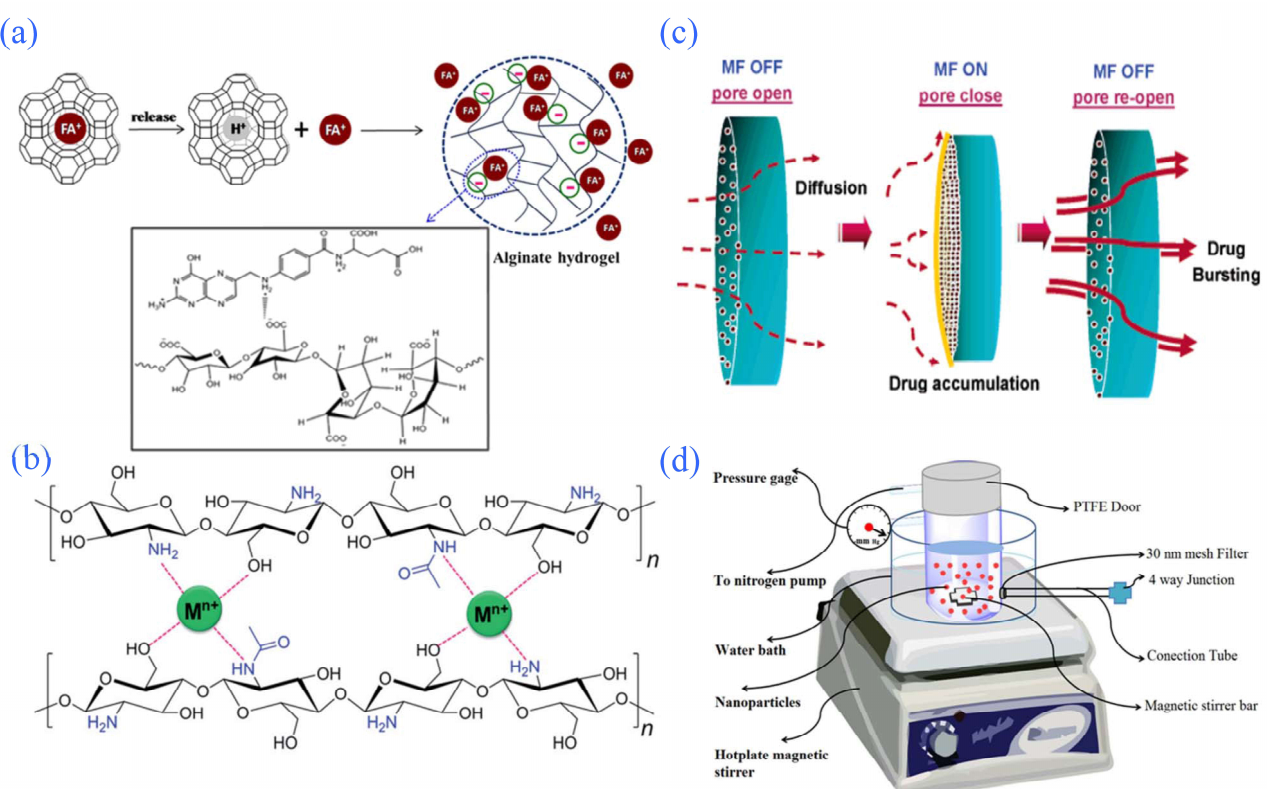
Figure 6. Partial intelligent-response hydrogel controlled-release system. ( a ) Proposed mechanism of FA release from zeolite FAY/alginate hydrogel. Reprinted with permission from Ref. [88]. Copyright 2015, Paradee, N. ( b ) Chemical structures of chitosan and their interwoven networks driven by the complexation between metal ions and OH and NH 2 groups in the chitosan chains. Reprinted with permission from Ref. [95]. Copyright 2015, Sun, Z. ( c ) Mechanism of “close” configuration of the ferrogels due to the aggregation of Fe 3 O 4 nanoparticles under a magnetic field causing the porosity of the ferrogels to decrease. Reprinted with permission from Ref. [97]. Copyright 2006, Liu, T. ( d ) Schematic of proposed device used for measuring the drug release from nanoparticles under pressure. Reprinted with permission from Ref. [106]. Copyright 2017, Hosseinifar, T.